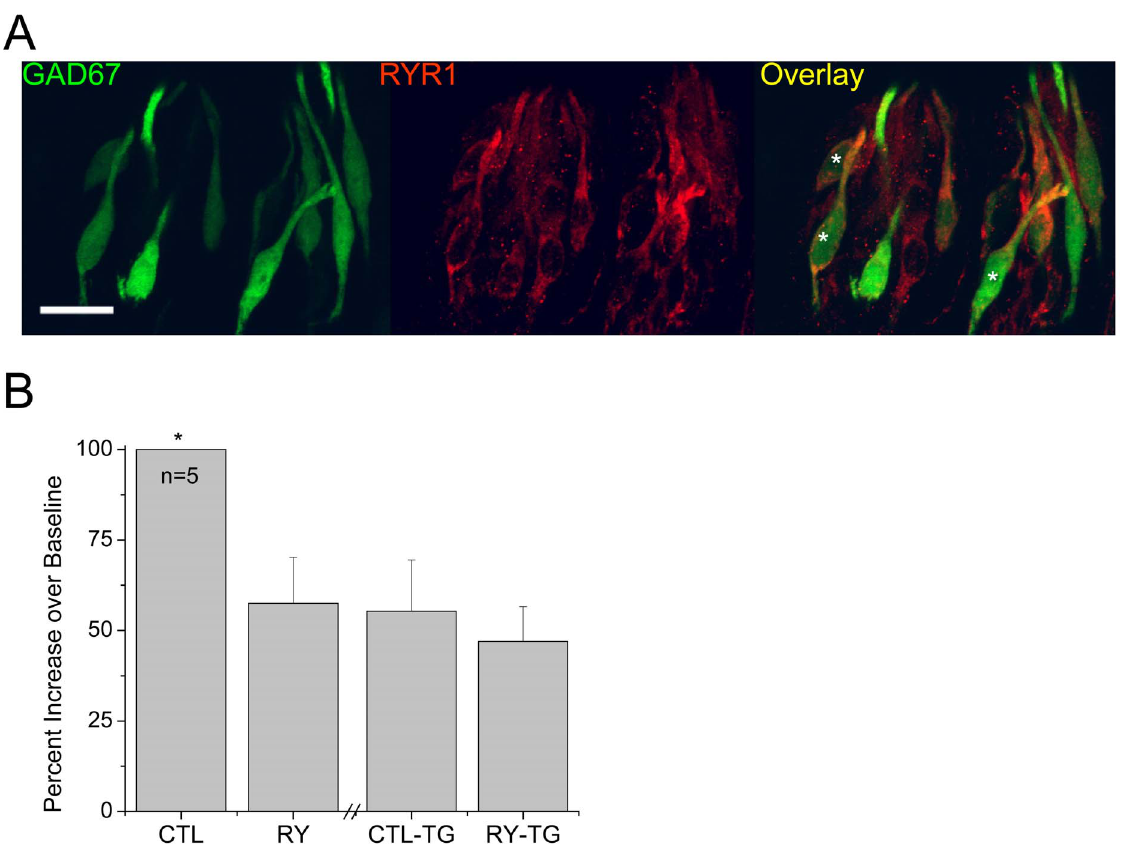
Figure 1. Many GAD67-GFP taste cells express ryanodine receptors. A) Immunocytochemical analysis reveals partial overlap of GAD67-GFP expression (green) and RyR1 immunoreactivity (red). Left panel shows GAD67-GFP expression, middle panel shows RyR1 immunoreactivity and right panel shows the overlay. Representative cells with co-localization are starred (*). Scale bar=20 m M. B) Analysis using a one-way ANOVA with Bonferroni’s post-hoc analysis found that ryanodine significantly inhibited the depolarization induced calcium influx (n=4, *p=0.013). After thapsigargin application, ryanodine had no significant effect on the calcium influx.